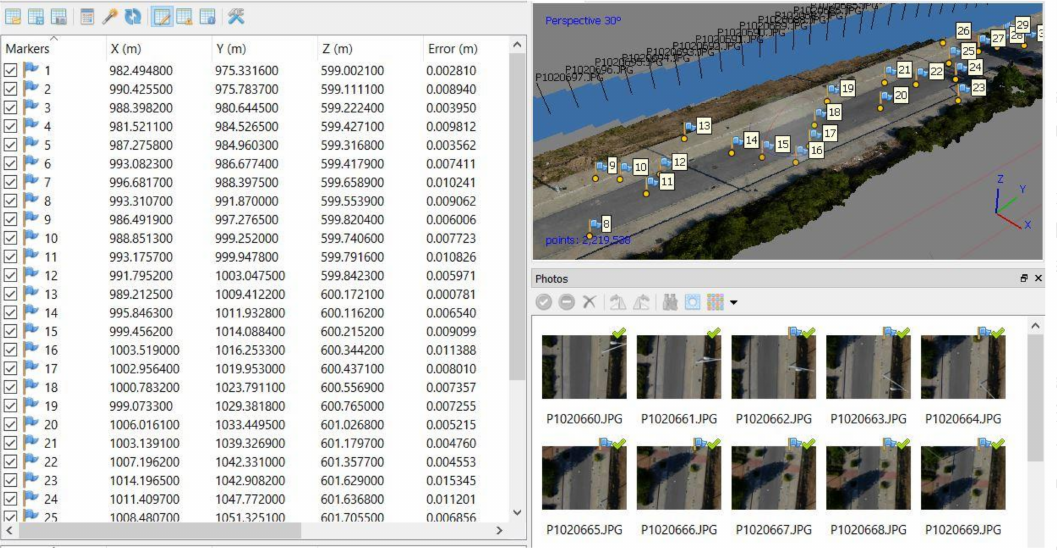
Figure 4. Development of the point cloud (PC). The first column shows the GCP number, the following three show the real GCP (ground truth), and the last one shows the square error between the PC generated by photogrammetry with respect to the ground